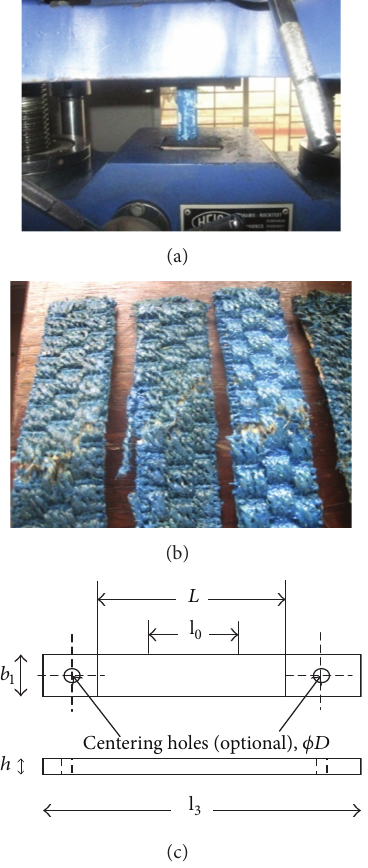
Figure 2: (a) Tensile testing; (b) tensile fracture samples of woven sisal FRP composite; (c) dimensions of the sample for tensile